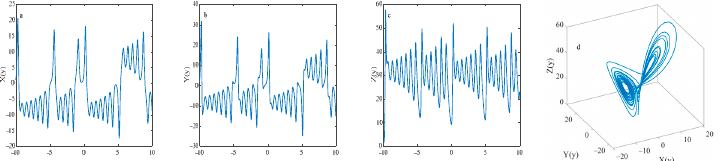
Figure 5. A typical plot of Lorenz chaotic dynamic system when a = 8, b = 33, c = 2.2, X ( 0 ) = 1, Y ( 0 ) = 2 and Z ( 0 ) = 1, chaotic solutions of X(y) ( a ), Y(y) ( b ), Z(y) ( c ) and chaotic attractor system ( d ).